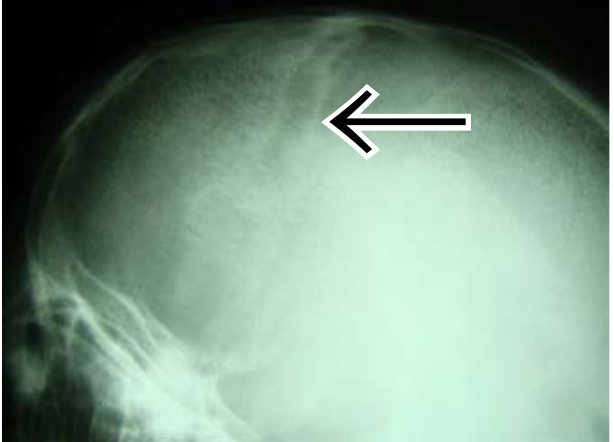
Fig. 2d. Coronal sutural defect – less commonly seen.